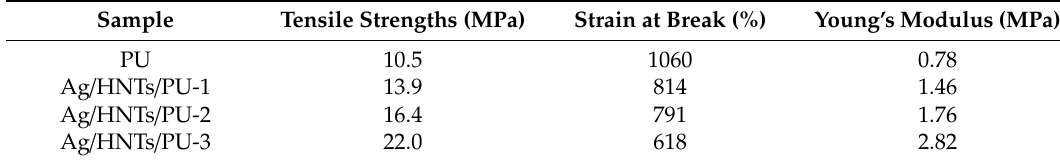
Figure 9. Tensile properties of the Ag / HNTs / PUs stress–strain curve. Table 5. Tensile properties of the Ag / HNTs /